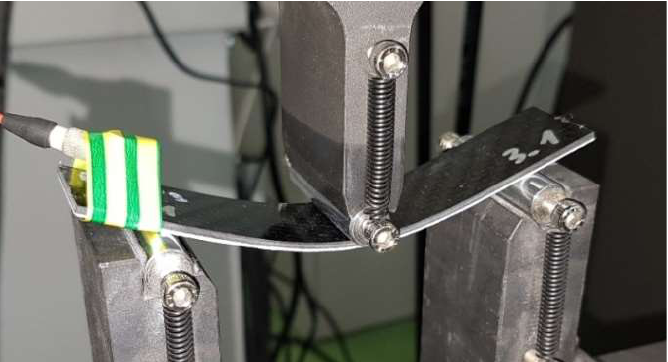
Figure 5. Displacement-controlled 3-PB deformation process of the sample with powder PL placed at the bottom. the